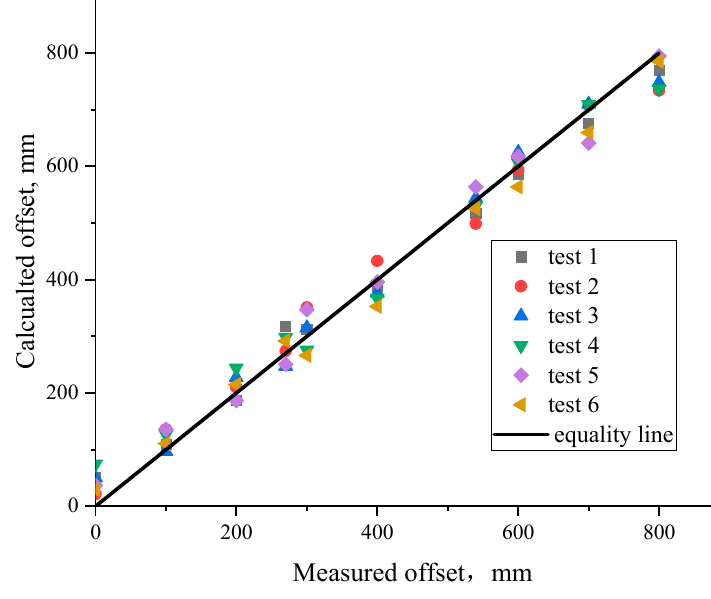
Figure 5. Calculated offset vs. measured offset.